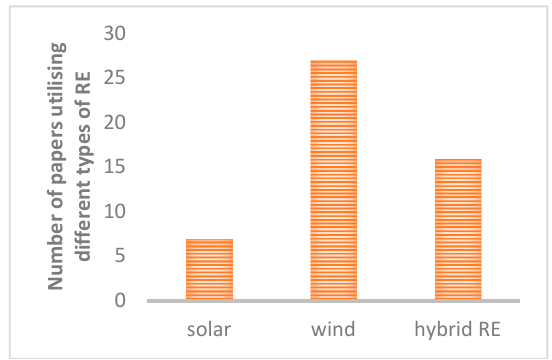
Figure 9. Distribution of empirical data by renewable energy resource.